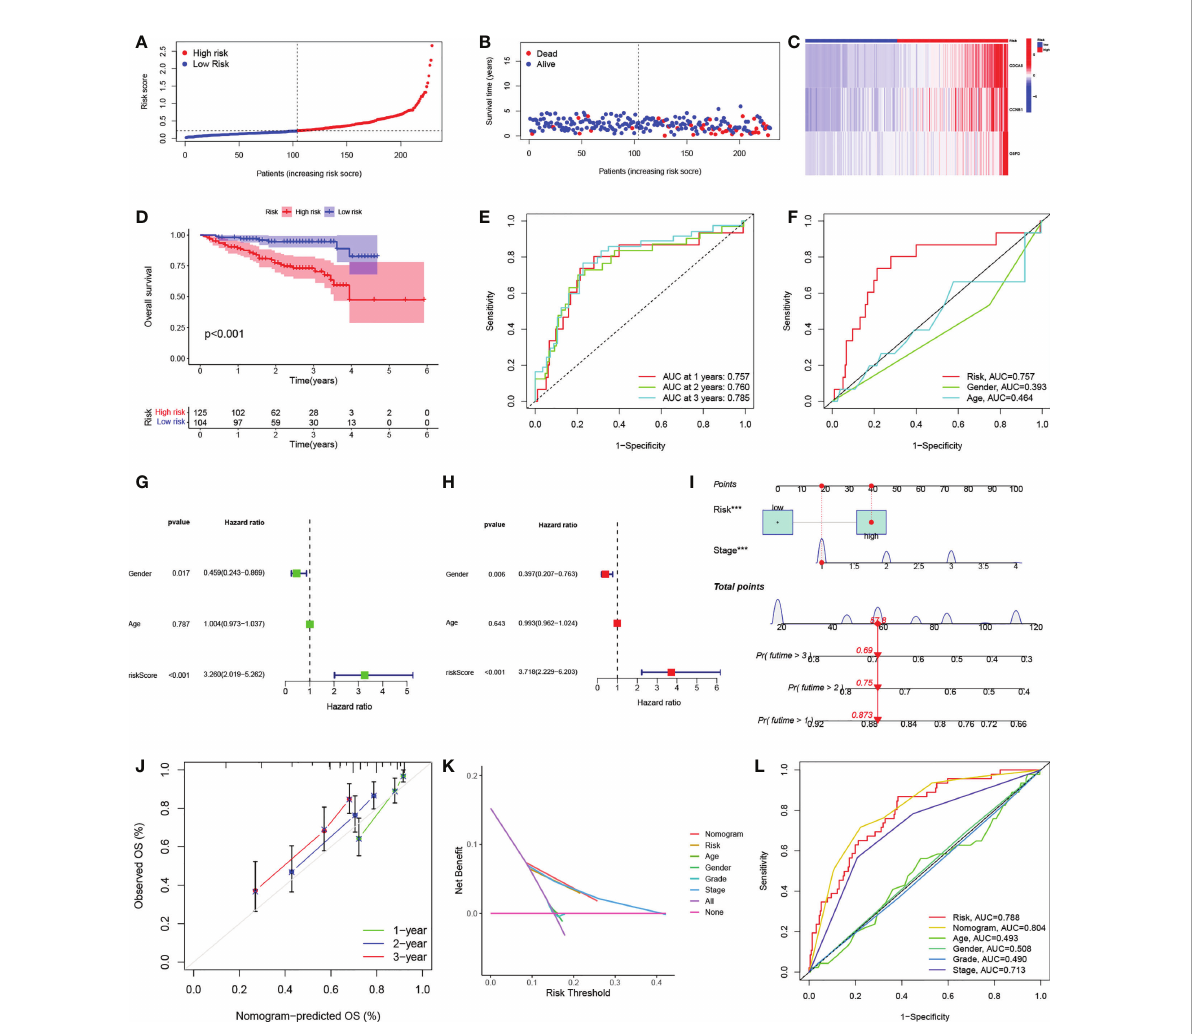
FIGURE 5 Independent veri fi cation of risk signatures and construction of nomograms. (A) Distribution of HCC patient risk scores in the ICGC cohort. (B) Scatterplot showing HCC patient OS in the ICGC cohort. (C) Heatmap of the expression of the three signature genes in high- and low-risk groups in the ICGC cohort. (D) K-M curves for HCC patient OS in the risk score-based ICGC cohort. (E) ROC curves of one-, two, and three- year prognostic signatures in the ICGC cohort. (F) ROC curves of one-year prognostic signatures with other clinicopathological characteristics in the ICGC cohort. (G-H) Forest plots of univariate and multivariate Cox regression analyses of prognostic signatures and other clinicopathological features in the ICGC cohort. (I) Nomogram combining risk signatures and clinical stages for OS prediction in the TCGA cohort. (J) Calibration plots for nomograms at one, three, and fi ve years. (K) DCA of the nomogram, risk signature, and other clinicopathological features. (L) ROC curves of the nomogram, risk signature, and clinicopathological characteristics at one year. HCC, hepatocellular carcinoma; ICGC, International Cancer Genome Consortium; K-M, Kaplan-Meier; OS, overall survival; ROC, receiver operating characteristic; DCA, decision curve